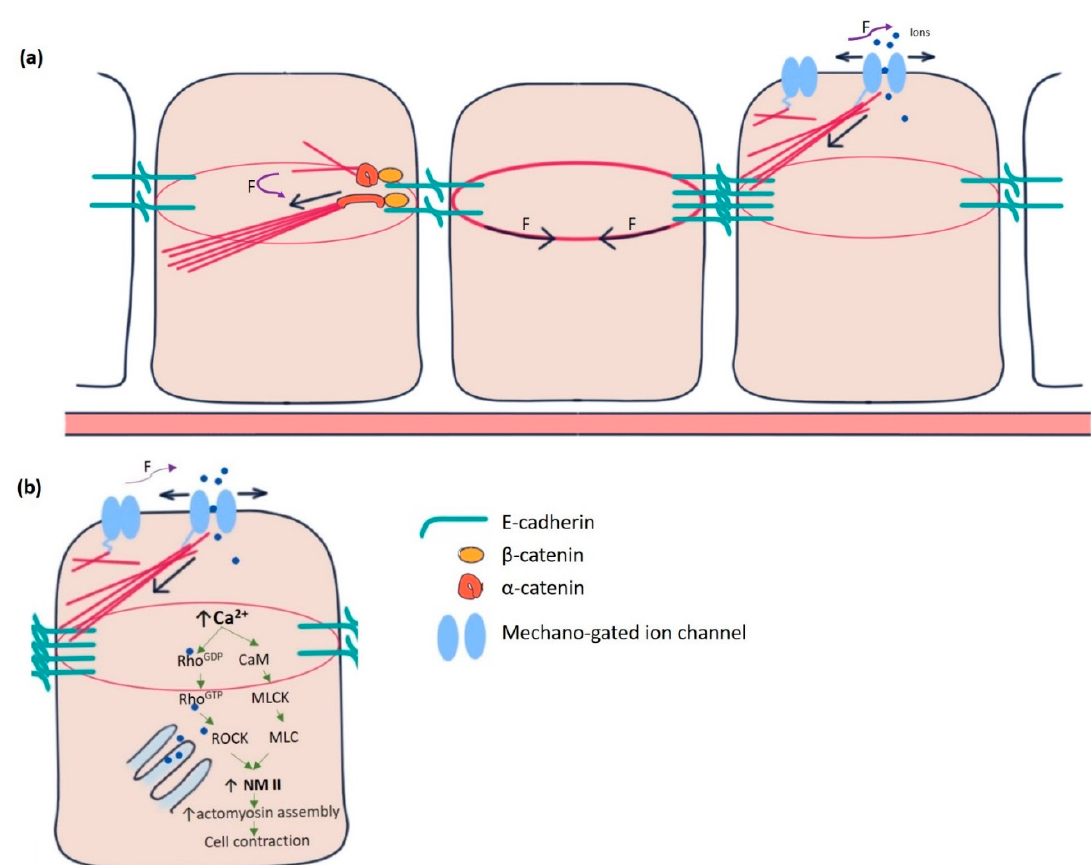
Figure 1. Mechanotransduction machinery in epithelial cells. ( a ) The E-cadherin-catenin complex is the key to adherens junction-mediated mechanotransduction. Pulling force (F) due to the contractile actin ring of the cell at the centre promotes a force-induced conformational change in α -catenin from closed to open conformation in the cell at the left. α -catenin at its open conformation binds with actin-binding protein vinculin and acts as an actin nucleator. Mechano-gated channels (in the cell at right) can sense forces directly from the membrane or the cytoskeleton. In response, they change conformation from closed to open state and allow the ions to flow in and out of the cell. ( b ) Increased intracellular Ca 2+ concentration in epithelial cells modulates the actomyosin assembly by activating non-muscle myosin II (NMII), the principal effector molecule. CaM, Calmodulin, MLCK, myosin light chain kinase, MLC, Myosin light chains, ROCK, Rho-associated kinase.